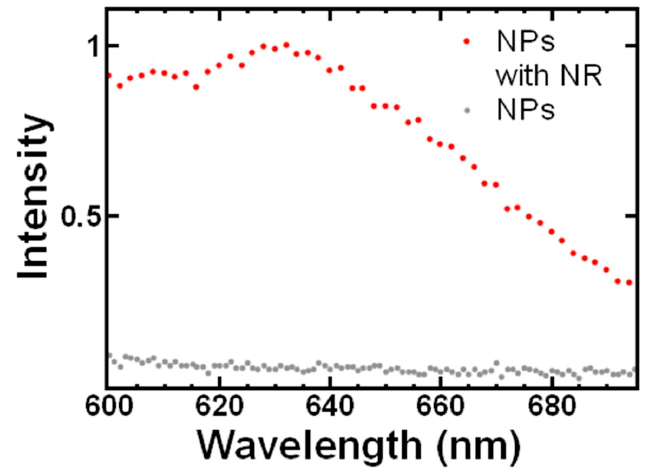
Figure 5. Fluorescence emission spectra (normalized) of fluorescent dye containing nanoparticles compared to tannic acid (TA)-chitosan nanoparticles.